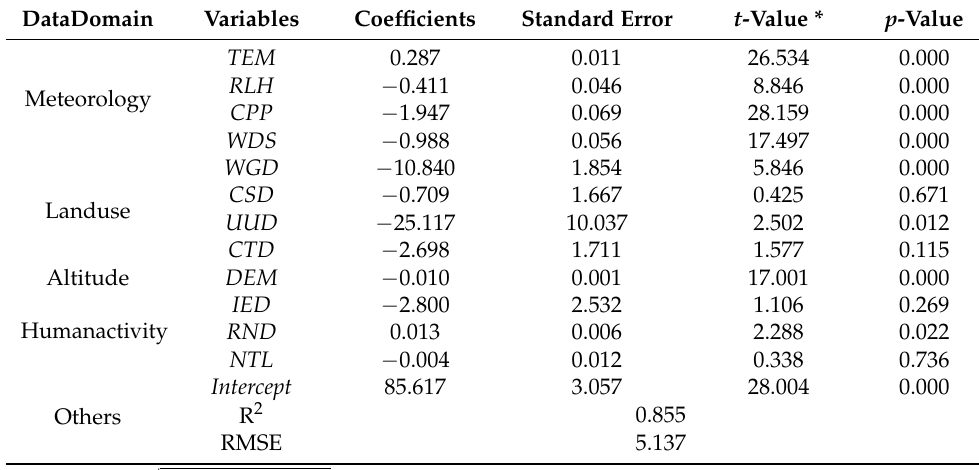
Table 2. Model estimation results from